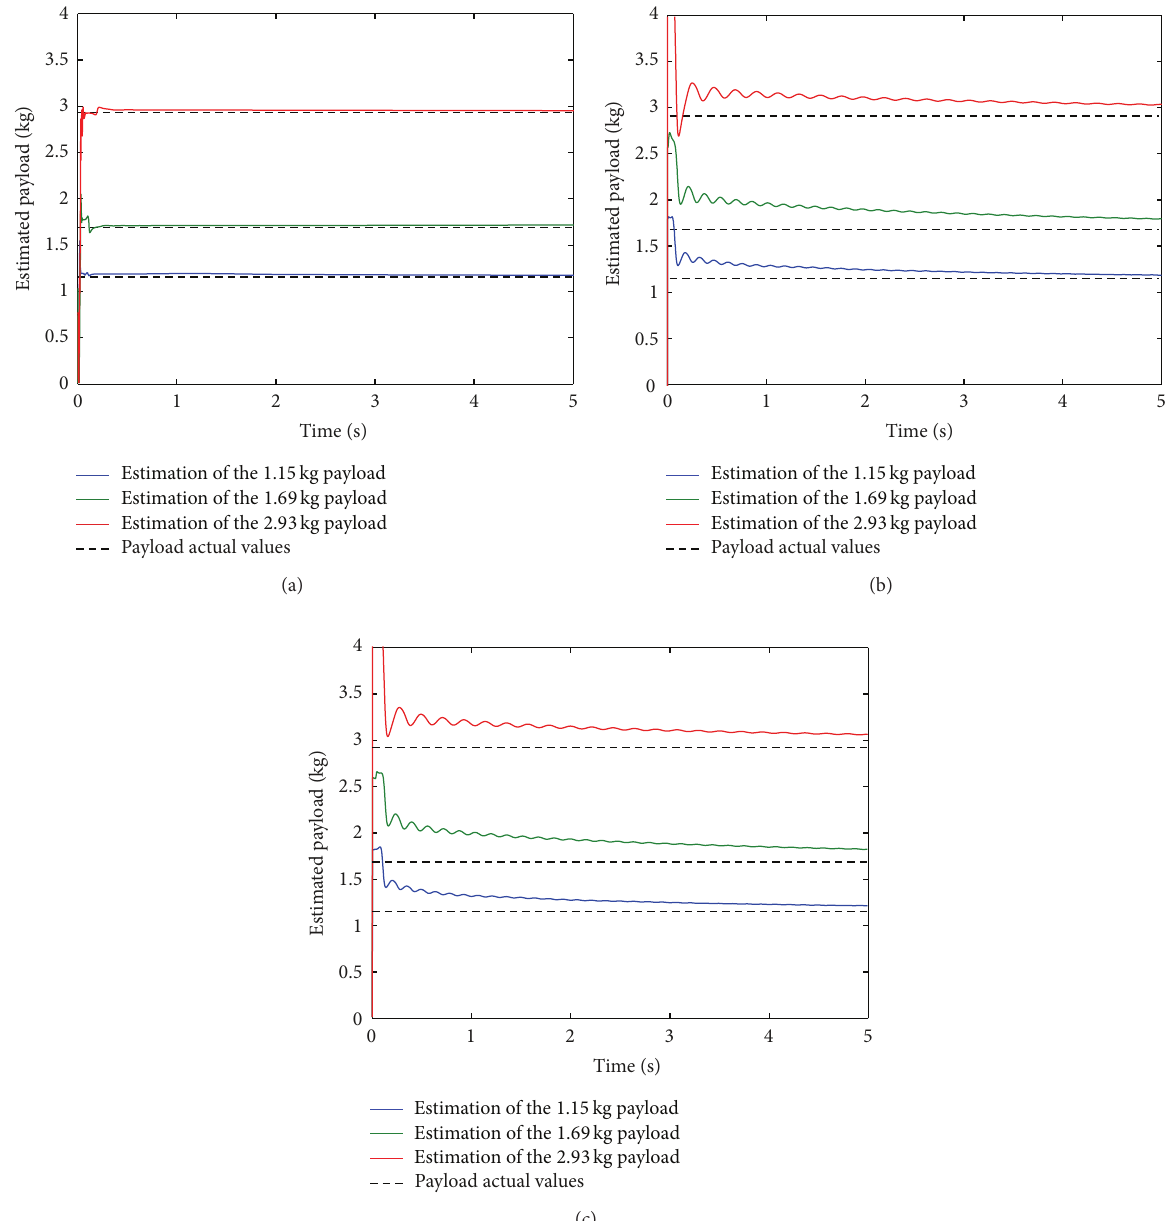
Figure 10: Experiment type 3: (a) algebraic identifier, (b) least square fitting, and (c) least square fitting with